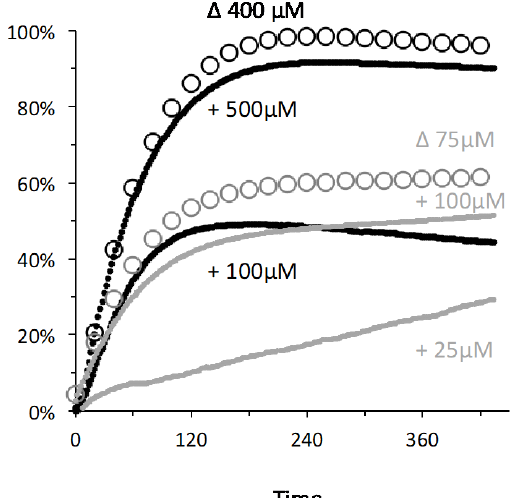
Figure 2. Increase in oxygen content in the medium compared to a full catalase reaction: X axis = time in seconds with addition of H 2 O 2 considered as zero time; Y axis = oxygen release expressed as percentage of the amount expected from a 100% yield for the catalase reaction (O 2 = ½ H 2 O 2 ). The two experiments presented in Figure 2a are in black symbols ( + 100 and + 500 µ M H 2 O 2 ) while those presented in Figure 2b are in grey ( + 25 µ M and + 100 µ M). Empty symbols represent results obtained when subtracting the oxygen release in the two concomitant chambers, i.e., either 100 − 25 = 75 µ M H 2 O 2 or 500 − 100 = 400 µ M, with one data point out of ten shown for the sake of